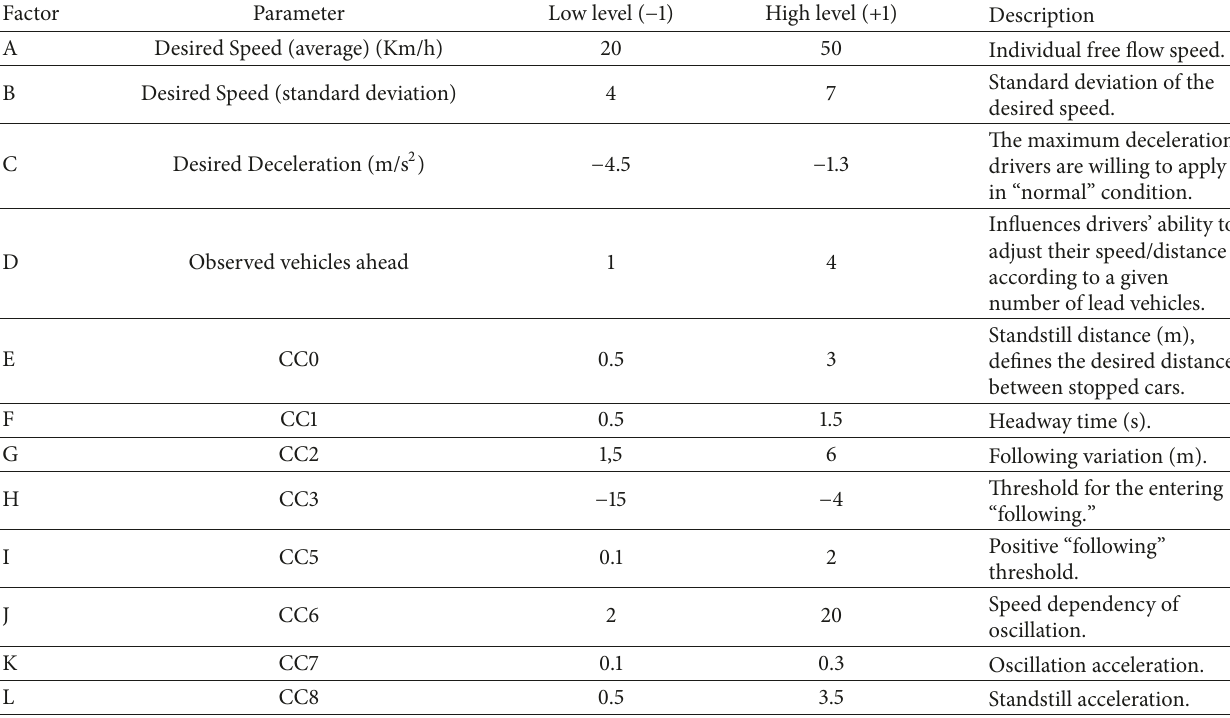
Table 5: Wiedemann 99 input parameters’ low and high values and their short description.